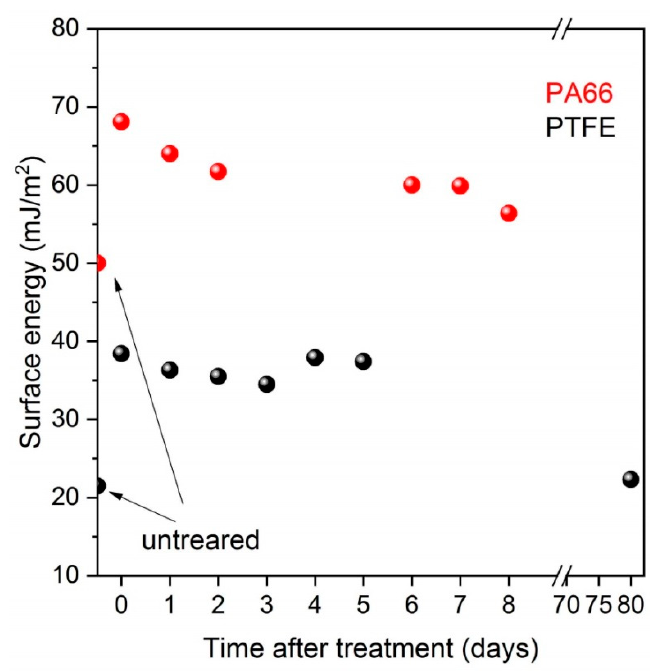
Figure 1. Surface energy values of the investigated polymers after DCSBD treatment as a function of time.